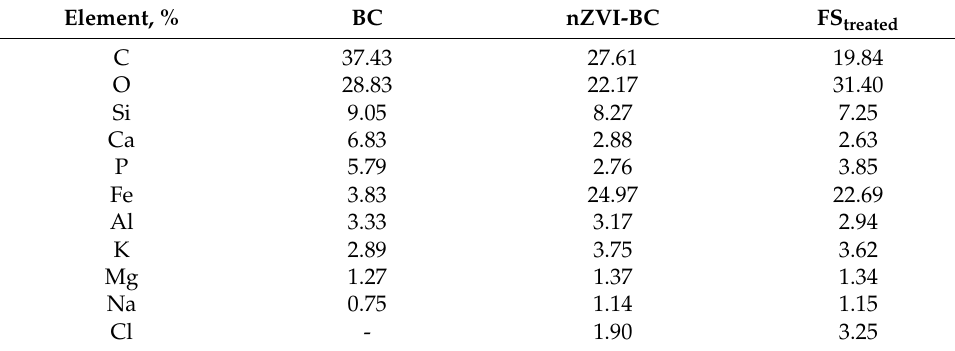
Table 1. Results of EDS analysis for BC, nZVI-BC, and FS treated. Element, %